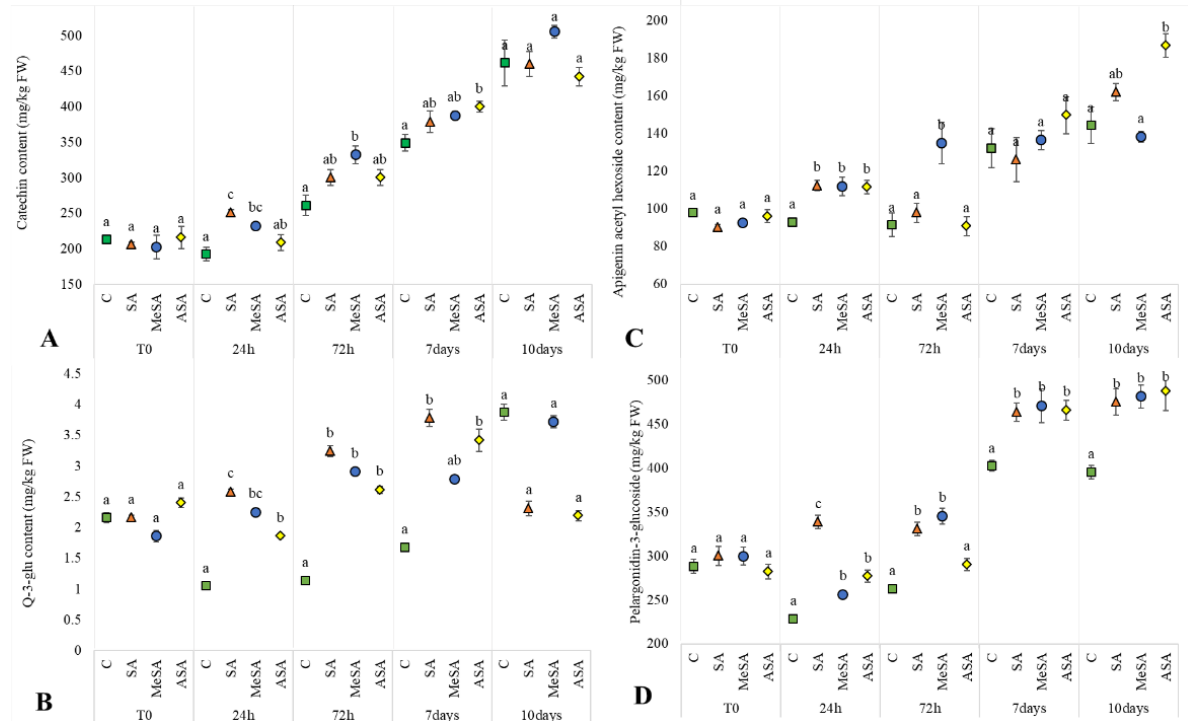
Figure 2. Content of catechin ( A ), quercetin-3-glucoside ( B ), apigenin acetyl hexoside ( C ) and pelargonidin-3-glucoside ( D ) (mg/kg FW) in C-control ( ◼ ), SA-salicylic acid ( ▲ ), MeSA-methyl salicylic acid ( ● ) and ASA-acetyl salicylic acid ( ◆ ) treated strawberry fruits at different time points (T0, 24 h, 72 h, 7 days and 10 days after treatments). Different letters (ac) denote a significant difference between treatments (C, SA, MeSA and ASA), obtained with the Tukey test ( p < 0.05). Data are presented as average value ± standard error ( n = 15).